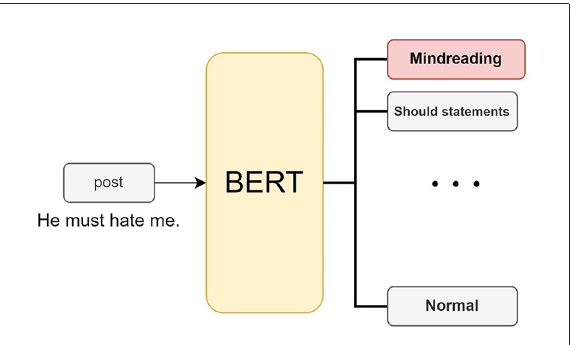
FIGURE2 We use BERT to identify cognitive distortions. Users input the text, and the model can output the categories of cognitive distortions it